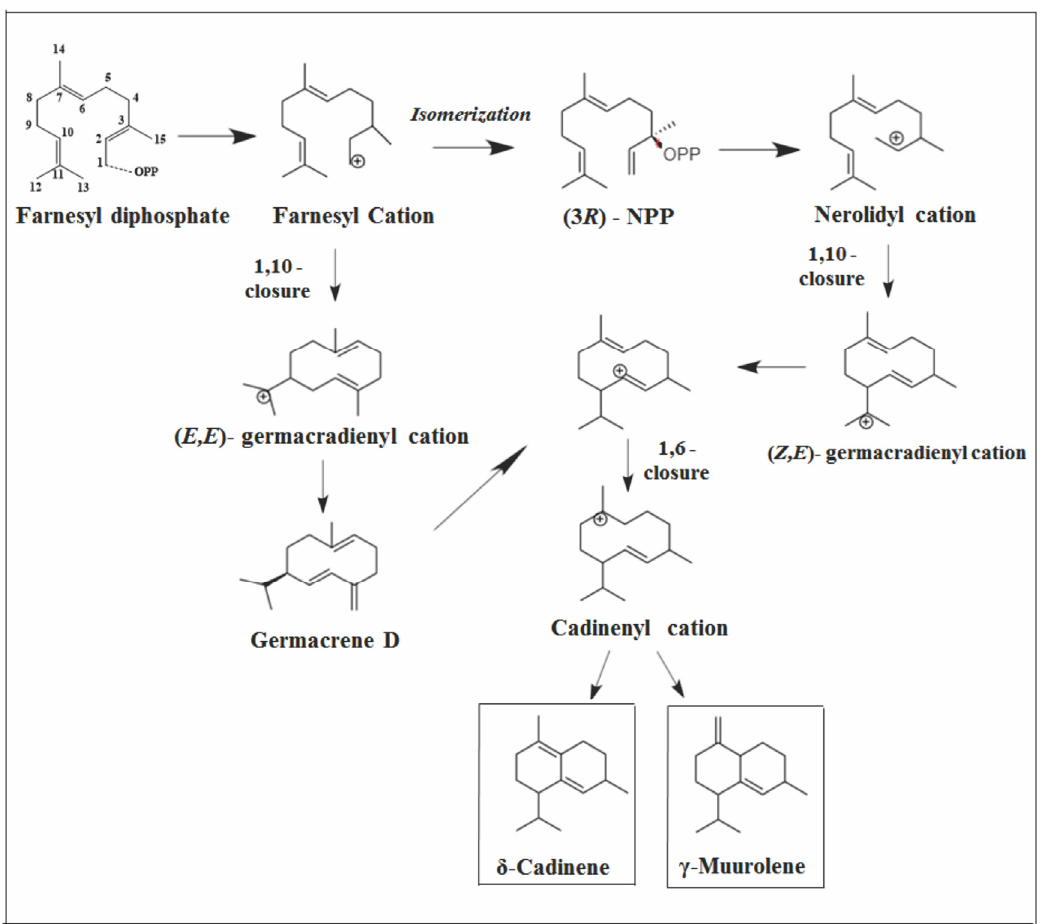
Figure 10. Types of primary cyclization of compounds δ -cadinene and γ -muurolene.